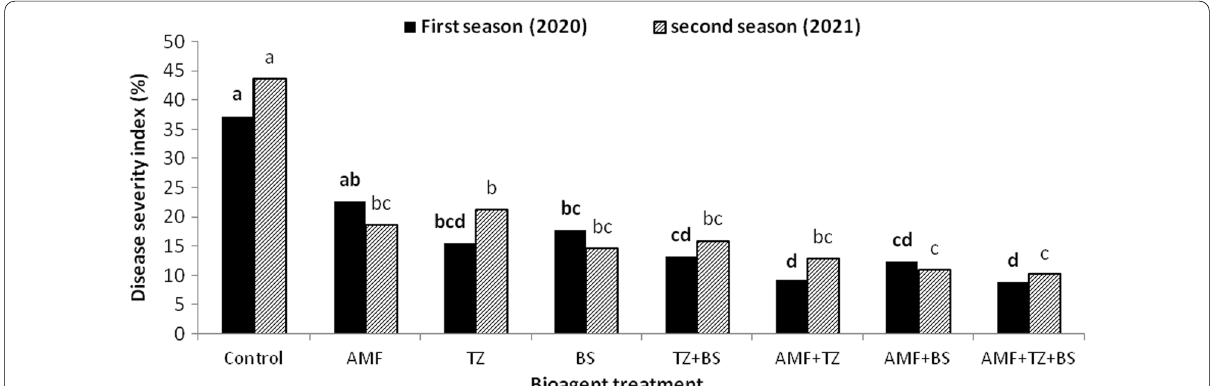
Fig. 4 Effect of AMF and PGPRs on DSI of squash root rot caused by Fusarium solani under field conditions during 2020 and 2021 seasons. Bars with different letters are significantly different (LSD, P > 0.05). Arbuscular Mycorrhizal fungi (AMF), Trichoderma harzianum ( TZ ) , Bacillus subtills (BS), control (without